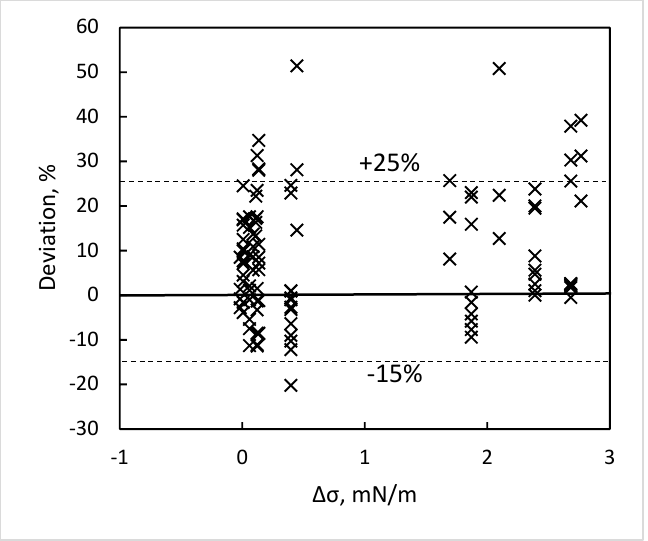
Figure 6. Effect of Δσ on deviations of the Shah (2015a) [21] correlation with data for CHF in annuli.